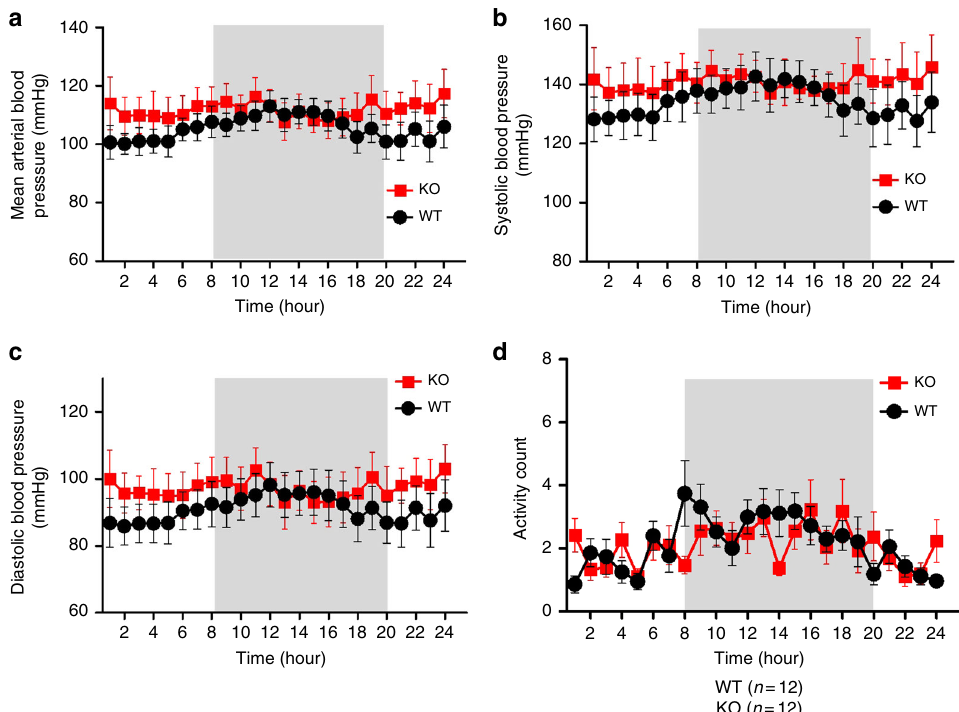
Fig. 1 Cardiovascular and behavioral activities in freely moving WT mice and Trpc5 − / − mice. Shown are 24 h recording of mean arterial pressure ( a ), systolic pressure ( b ), diastolic pressure ( c ) and activity count ( d ). The recordings were performed from 1000hours to 1000 hours of the next day. Shaded areas represent dark period when the light was switched off (1800 hours to 0600 hours of the next day). WT, wild-type mice; KO, Trpc5 − / − mice; n =